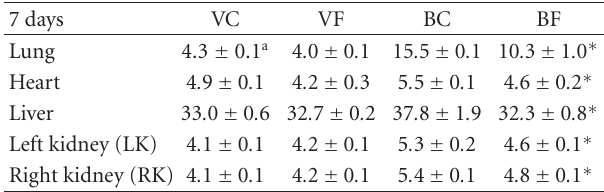
Table 2: Relative (normalized to body weight) weights (g) of organs at 7 days after bleomycin treatment and averaged by experimental